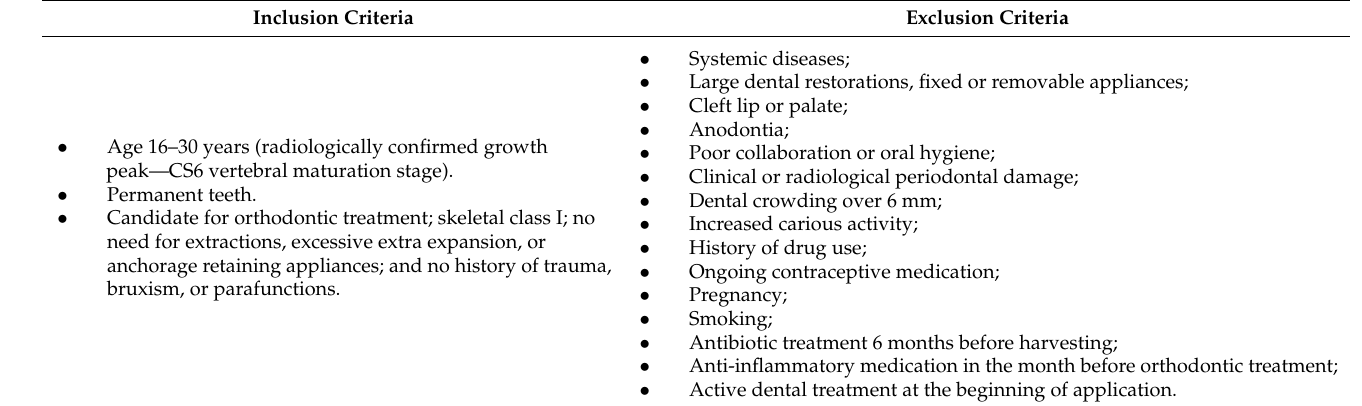
Table 1. Inclusion and exclusion